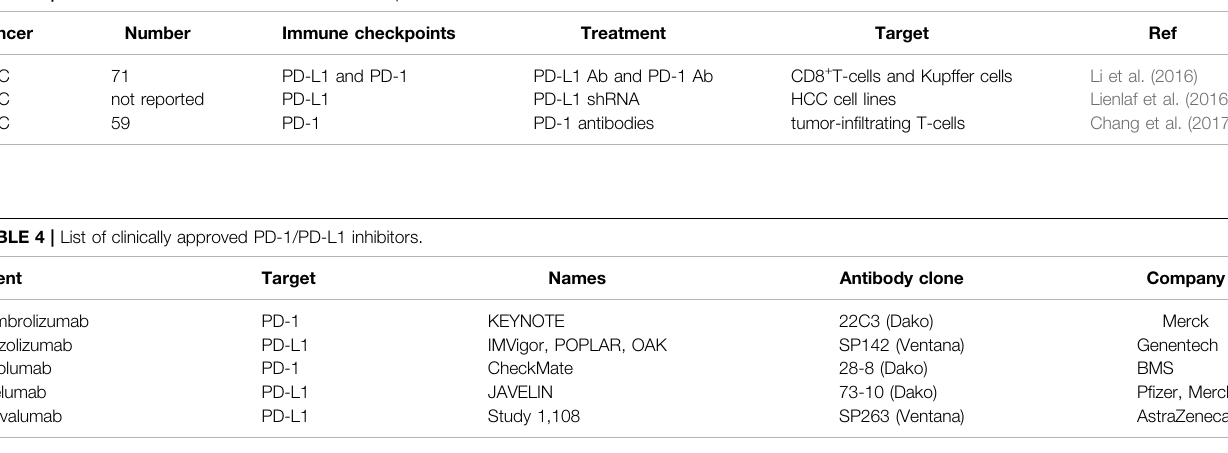
TABLE 5 | Cells expressing PD-1 and its ligands via different signaling molecules. Immune